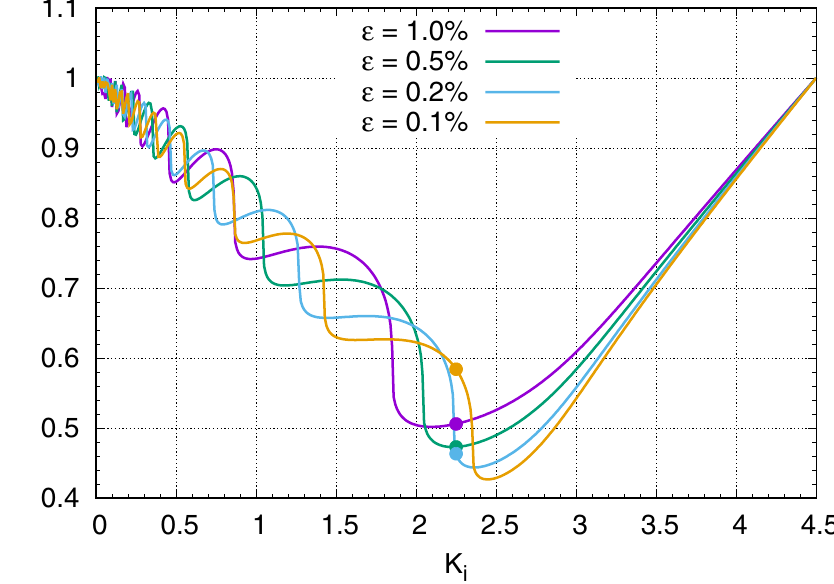
Figure 4. Plot of the normalized settling time, NST, versus the internal separation factor, K i , for a three-pole system designed with the constraint in (16) and for different accuracy levels, (cid:101) . Colored spots identify the normalized settling-times observed at the optimum bias point set by (cid:63) ( K (cid:63) ) = ( 8/3,9/4 ) e , K i